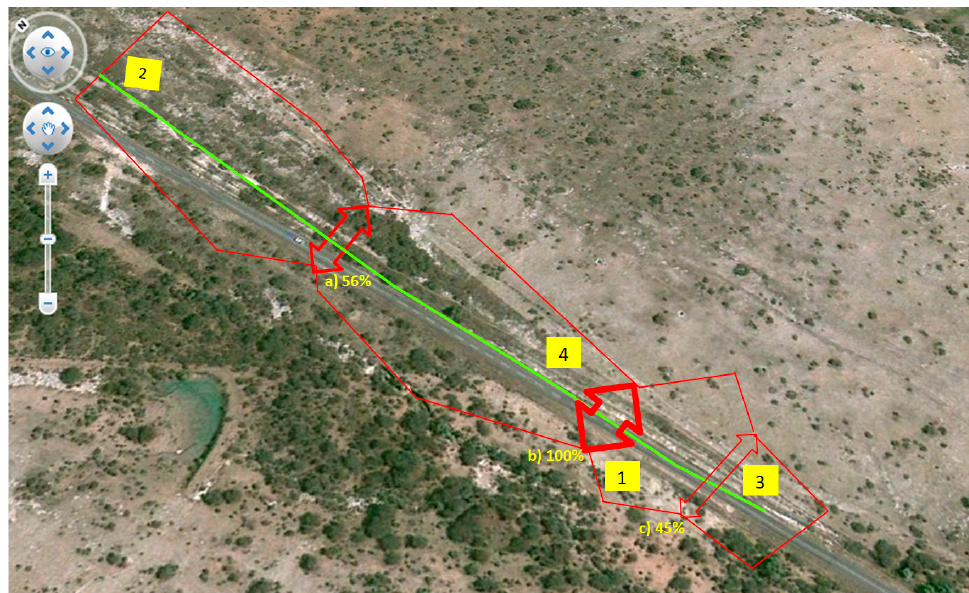
Figure 5. The three genetic barriers ( a , b , c ) to gene flow identified among the four patches (1, 2, 3, 4) of M. albiflora are indicated by the rows. The percentage beside each label of the barrier indicates the bootstrapped matrices that support them. The polygon constructed by barrier was drawn on a true image of the study area downloaded on September 2016 with the free application Google Maps. The geographic distance between patch 2 and 3 is of 4.2 km.